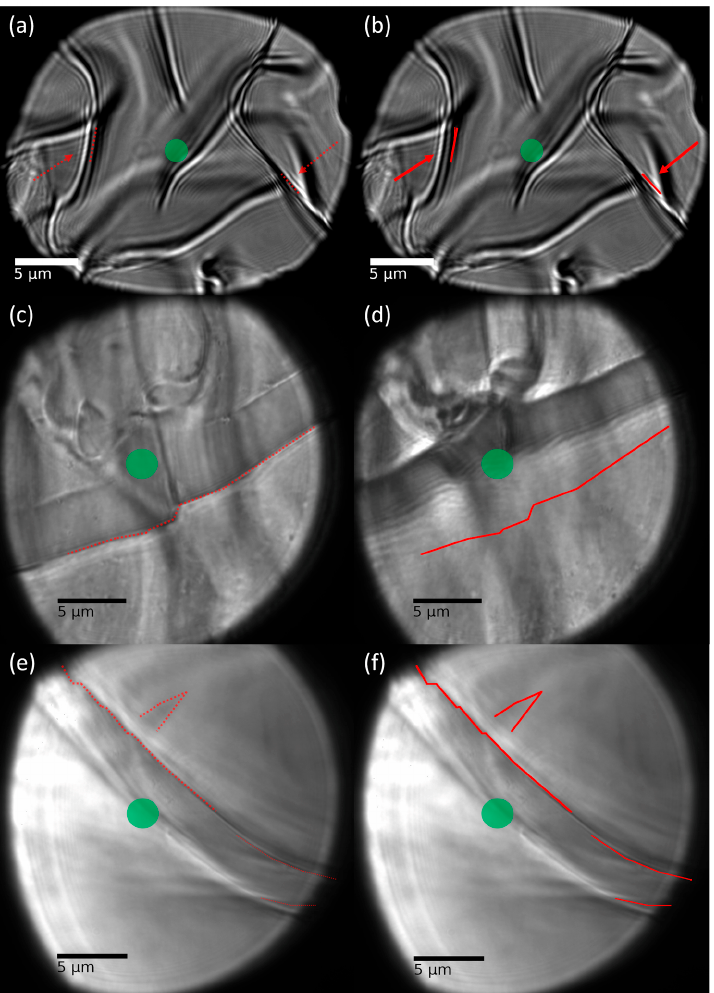
Figure 2. Light microscopy images of pristine (left panels) and photoactuated regions (right panels) of gel layers prepared from ( a , b ) poly(HEAm 96.5% -co-o-MREAm 2.5% -co-BPAAm 1% ) P NR , swollen in water, ( c , d ) poly(NipAAm 86.5% -HEAm 10% -co-o-MREAm 2.5% -co-BPAAm 1% ) P 22°C , swollen in water, ( e , f ) the same polymer in isopropanol. Photoactuation was performed with a laser at λ = 532 nm and 2600 µW (irradiation region marked by a green spot). Red lines and arrows indicate notable gel features that were photoactuated. Videos of the photomotion are provided in the download section of the supporting information.